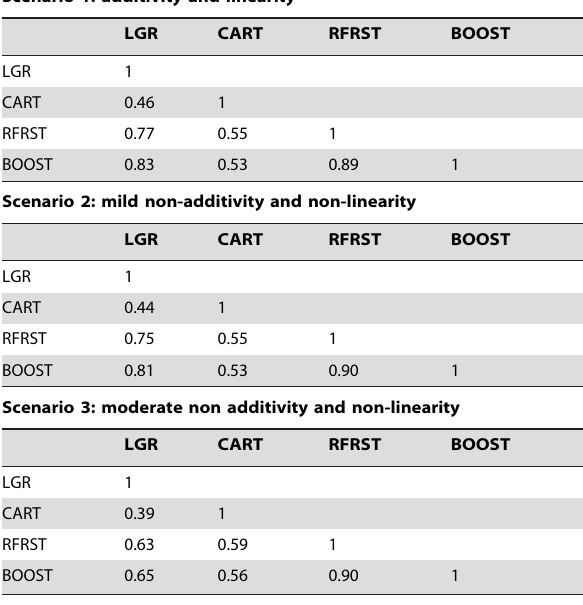
Table 2. Spearman Correlations of Estimated Propensity Score Weights by Estimation Method and True Propensity Score Model Scenario.